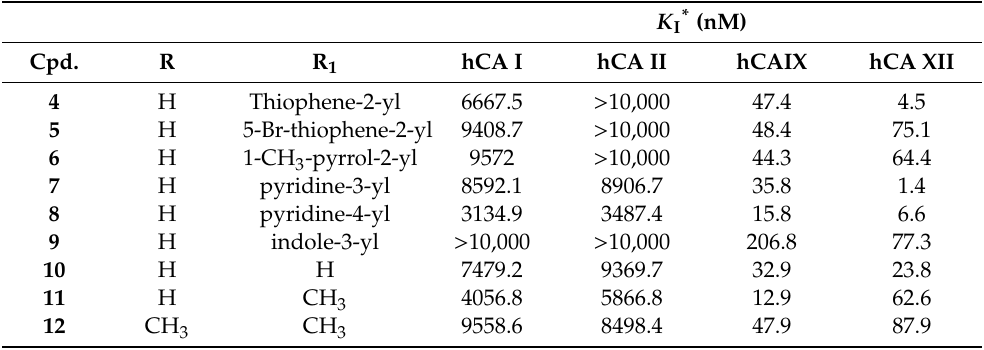
Table 1. Inhibition data of hCA I, II, IX, XII with compounds 4-24 and the standard inhibitor acetazolamide (AAZ) by a stopped flow CO 2 hydrase